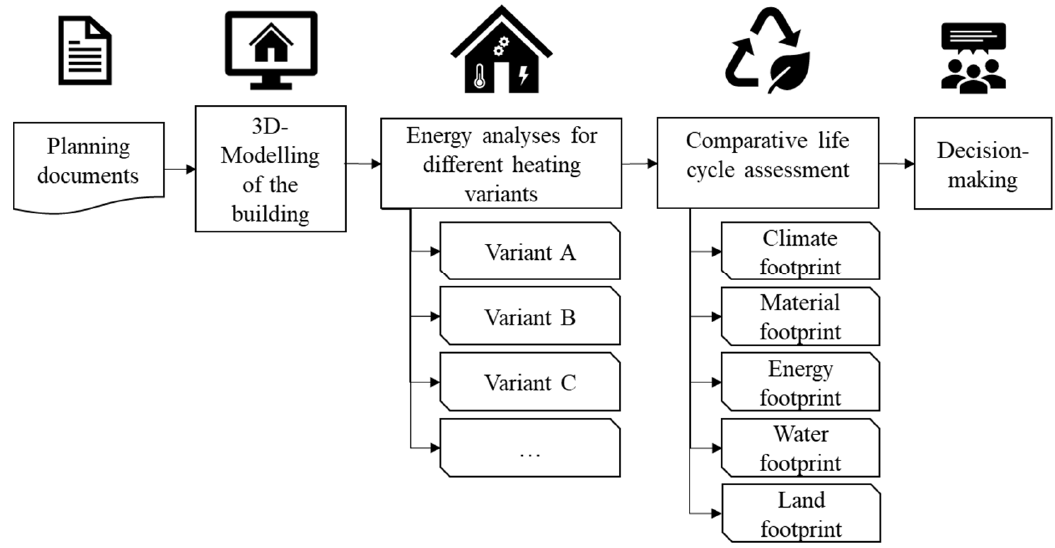
Figure 1. Research methodology.